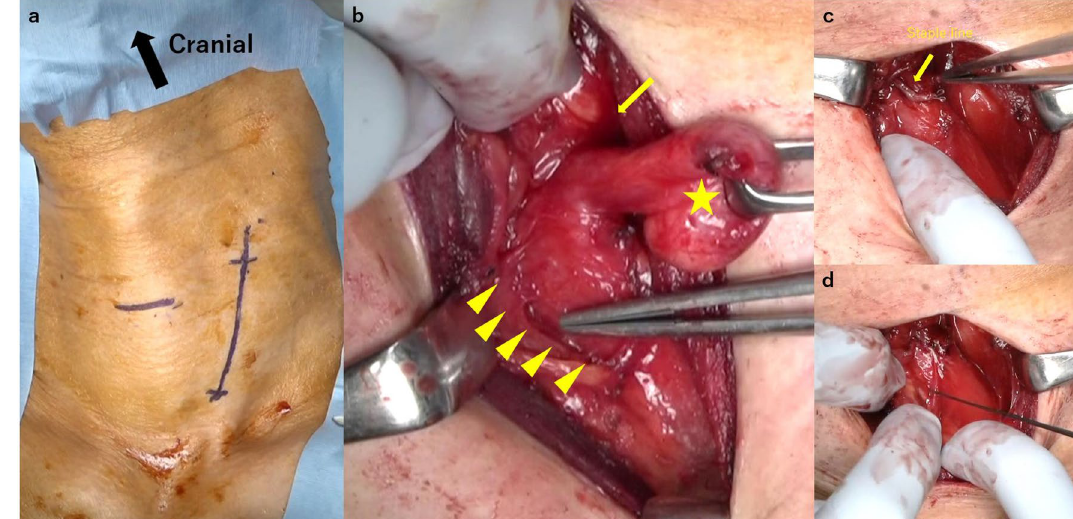
Fig. 2 Intraoperative picture. a The cervical esophagus was accessed through a 6-cm left oblique incision on the anterior border of the left sternocleidomastoid muscle. b Diverticulum exposed to the base (star) and the cricopharyngeal muscle (arrow) and the left recurrent nerve (arrowheads). c The diverticulum was transected longitudinally using a linear stapler. d The left recurrent nerve was preserved, using intraoperative neuro monitoring